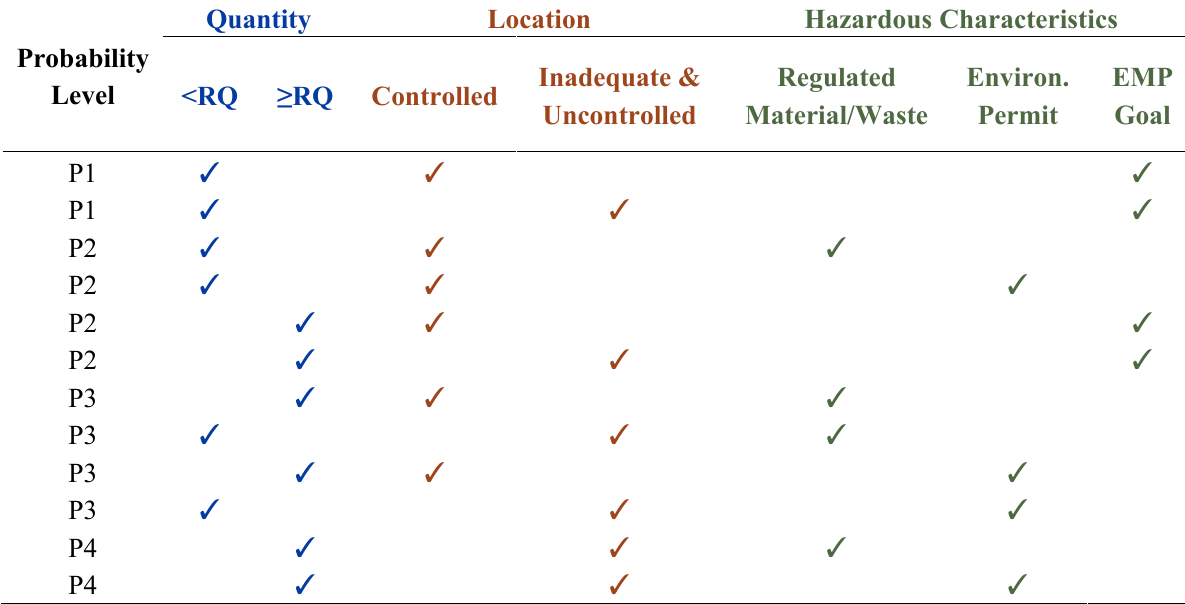
Table 1. Three factors affecting the probability of contamination of the environment. Quantity Location Hazardous Characteristics Probability Level <RQ ≥RQ Controlled